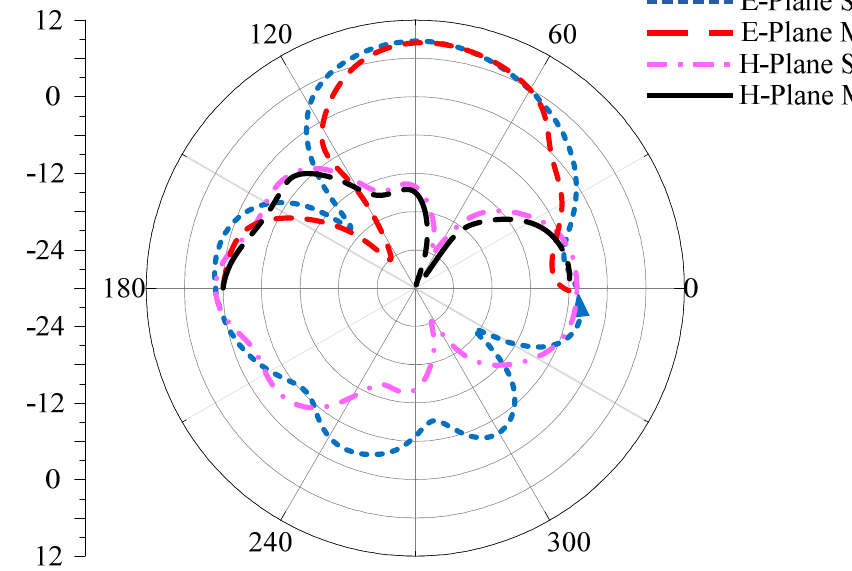
Figure 4. Radiation patterns of proposed antenna in E - and H -plane at 28 GHz.